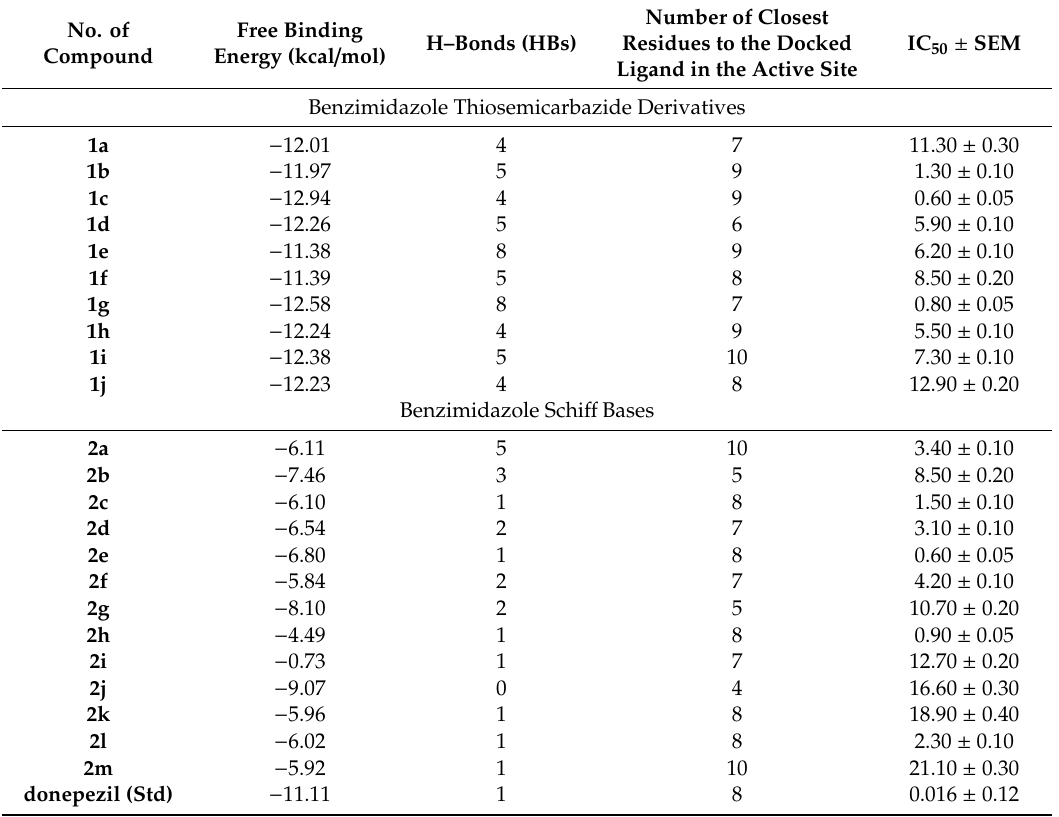
Table 3. Free binding energies, hydrogen bonding, and number of closest residues to the docked benzimidazole thiosemicarbazide derivatives 1 (a – j ) and benzimidazole Schi ff bases 2 ( a – m ) into the binding site of acetylcholinesterase, and their IC 50